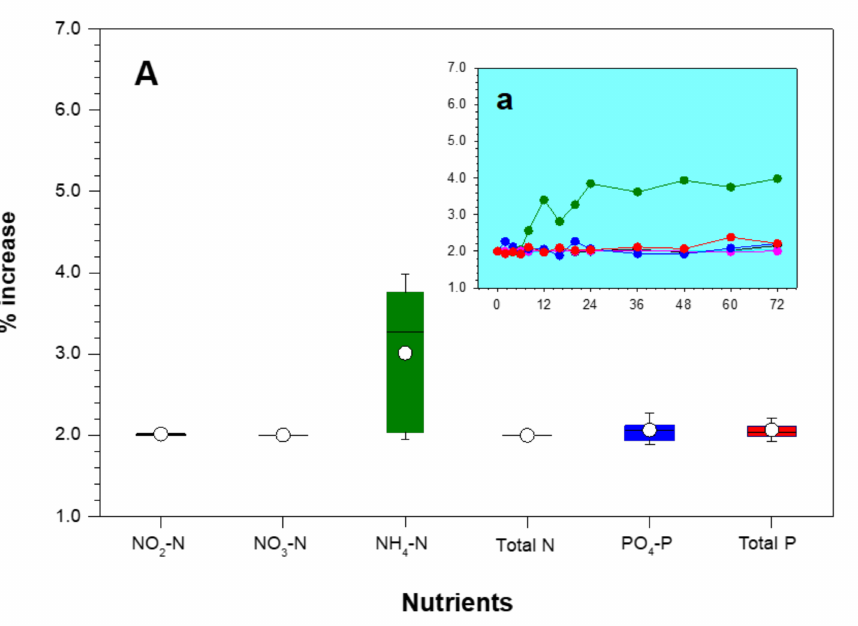
Figure 7. Relative increase of nutrient levels ( A ) and their variations in the experimental chambers ( a ) after introduction of Unio douglasiae to Microcystis -predominating waters for 72 h